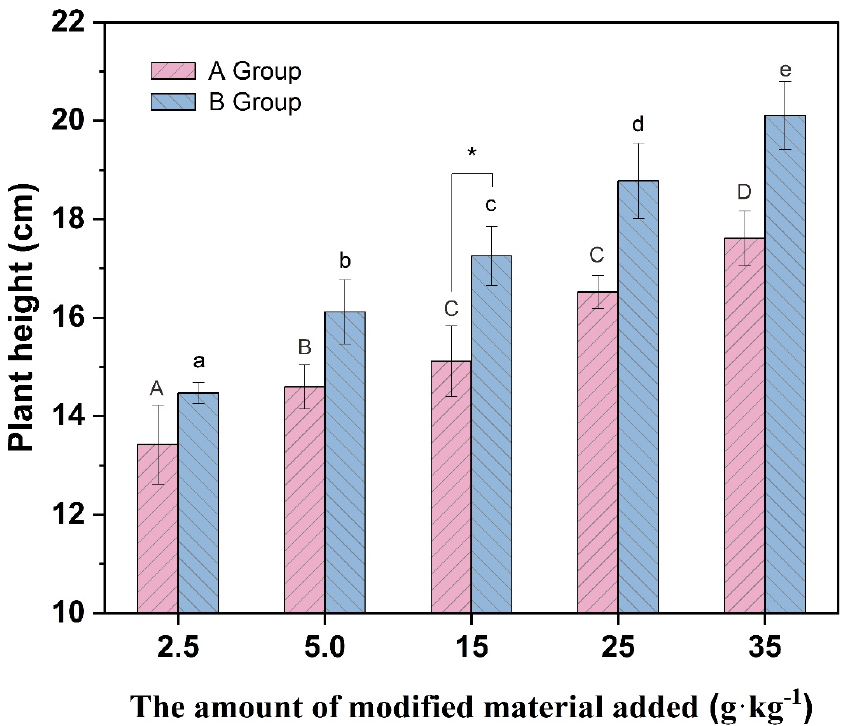
Figure 5. Plant height of different groups of vegetables. (* indicates values significant at p < 0.05). Different letters above the bar diagram indicate the significant difference of fresh weight of shoot in different groups of soil.